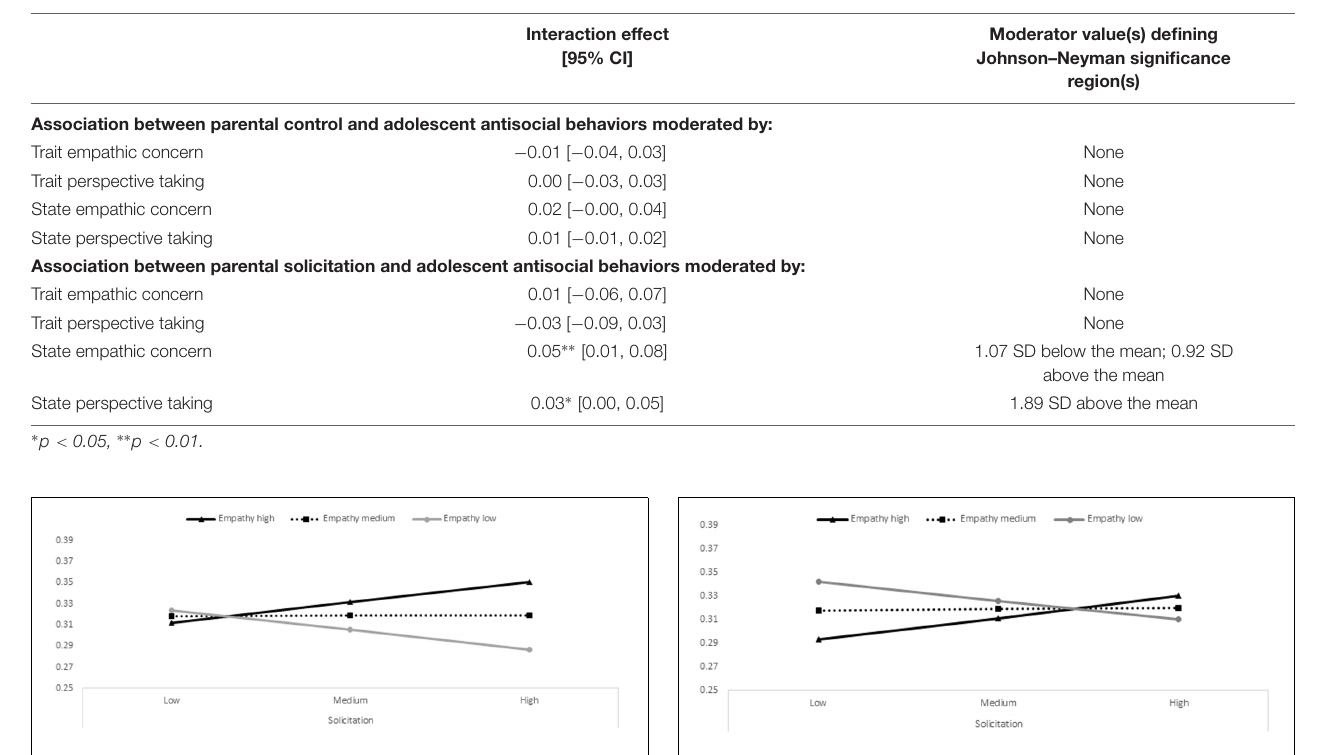
FIGURE 2 | Association between paternal solicitation at T1 (on the x -axis) with adolescent antisocial behaviors at T2 (on the y -axis) for low (gray line), medium (dashed line), and high (black line) levels of state empathic concern.